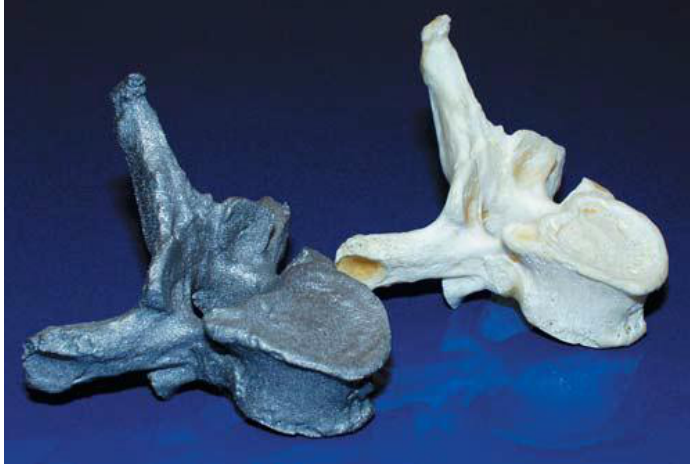
Figure 4. Example of an exact CT-based part of a complex human vertebra processed by SLM using additive manufacturing